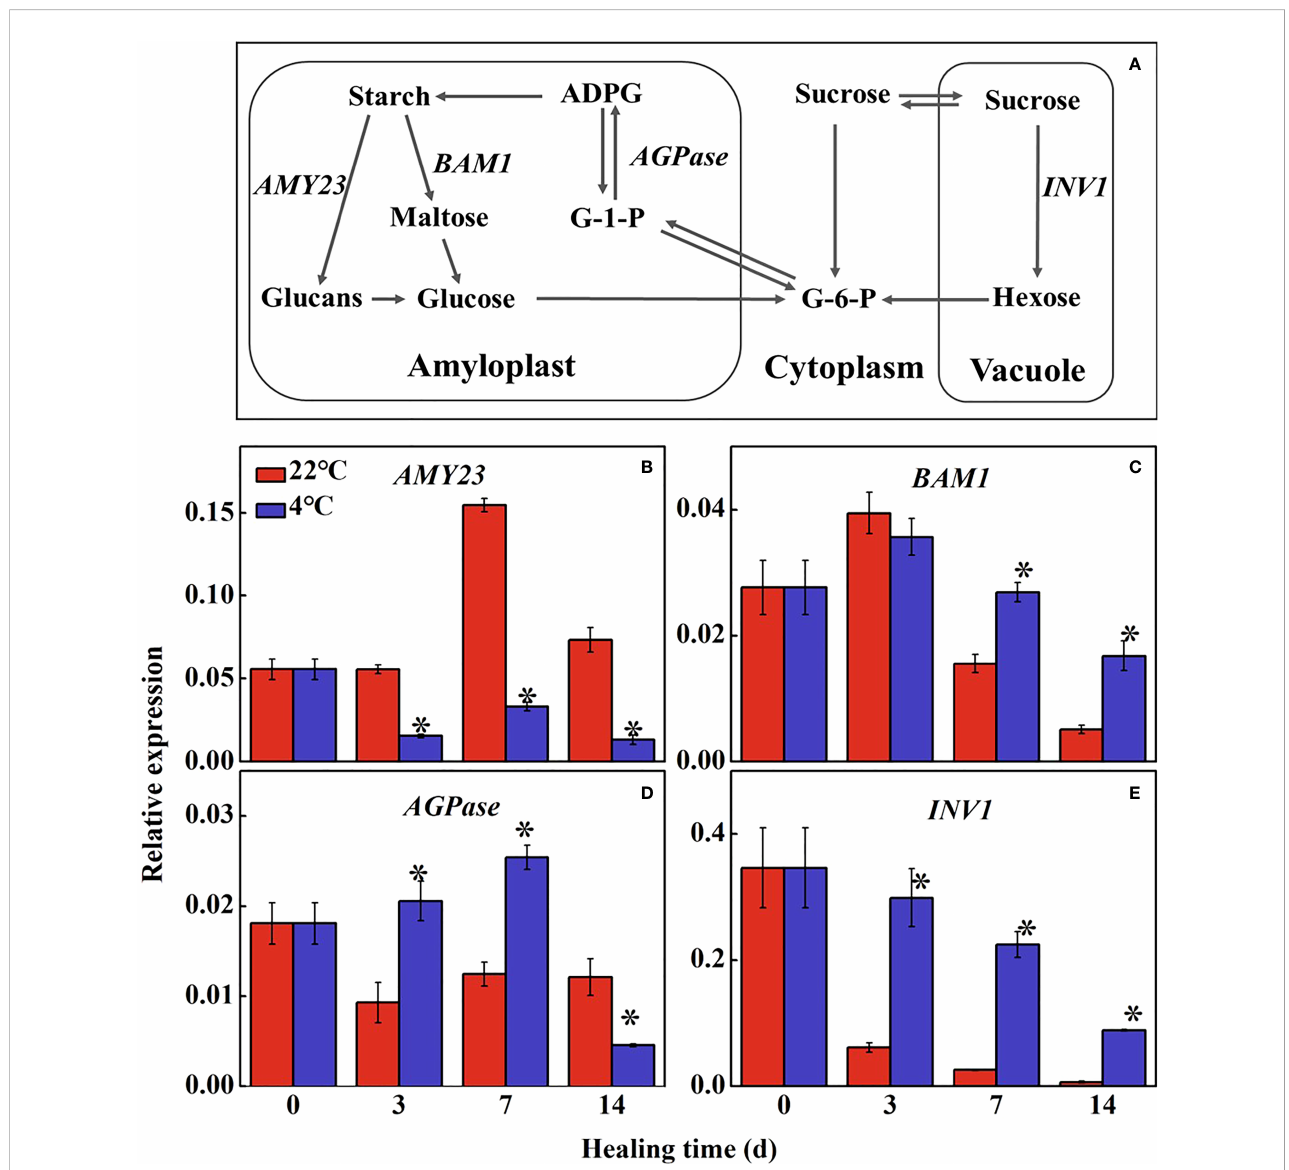
FIGURE 2 Figure 2. (A) The pathway of starch and sugar metabolism and effect of different temperatures on the expression of (B) alpha-amylase 23 (AMY23), (C) beta-amylase 1 (BAM1), (D) ADP-glucose pyrophosphorylase (AGPase) and (E) vacuolar1 (INV1) at the wound sites of potato tubers during healing. Starch is hydrolyzed into glucose under the alpha-amylase (AMY) and beta-amylase (BAM); G-6-P and glucose-1-phosphate (G-1-P) are interconverted to adenosine diphosphate glucose (ADPG) by ADP-glucose pyrophosphorylase (AGPase) for further starch synthesis. Sucrose is catalyzed into hexose (glucose and fructose) by sucrose invertase (INV). The symbol (*) indicates signi fi cant differences among different treatments at p <